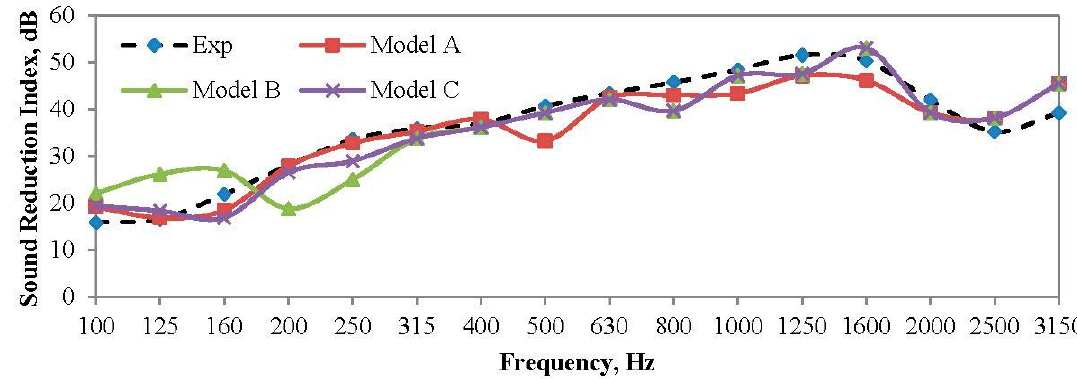
Figure 8. Comparison of Sound Reduction Index between the constant and frequency dependent mesh models